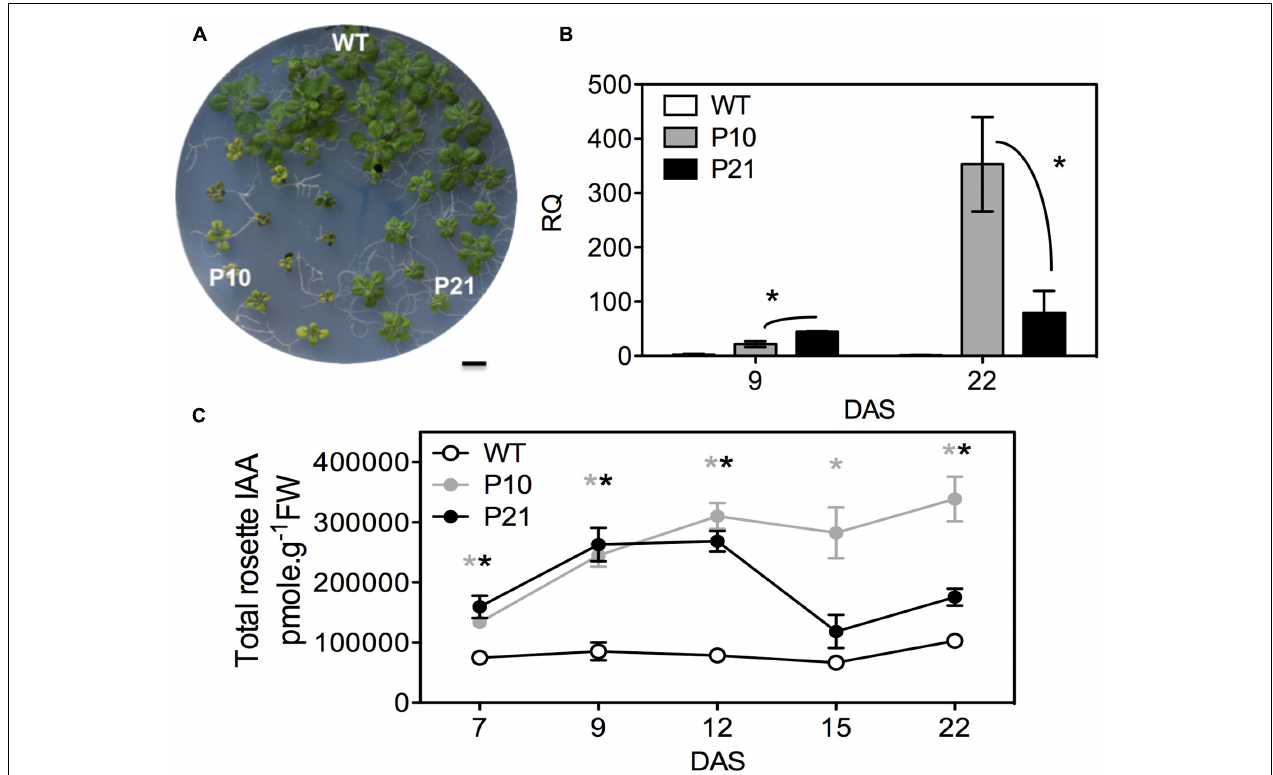
FIGURE 1 | Effect of PID overexpression on rosette phenotype and auxin pool in the whole rosettes. Rosette phenotypes of WT and two PID OE lines, P10 and P21, at 22 DAS (A) . Relative quantification (RQ) of PID transcript in the leaves of WT, P10, and P21 at two different time points, n = 3; Asterisks mark the significant differences between the PID overexpression ( PID OE ) lines (B) . Total auxin (indole-3-acetic acid; IAA) measurements in the rosettes (C) . The averages and standard error of relative expression are based on three biological replicates. Gray and black asterisks represent significant differences toward WT, for P10 and P21, respectively. DAS, days after stratification. Error bars: ± SE ( t -test P < 0.05). Scale bar = 10